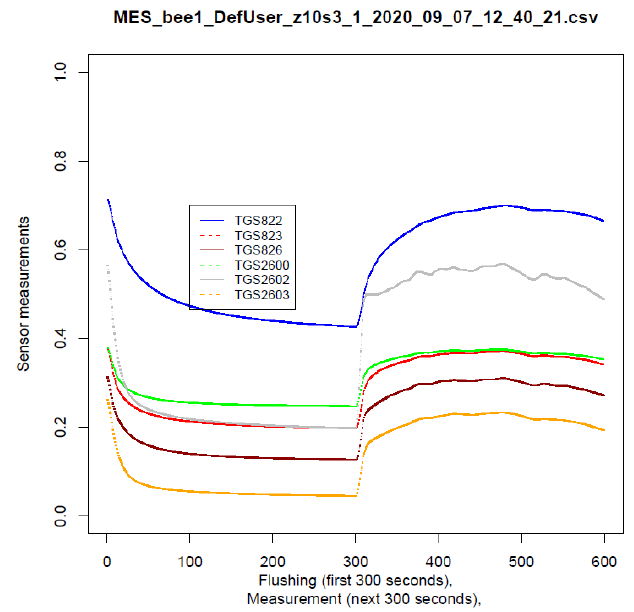
Figure 4. An example of a 600 s gas sensor reading, representing a single measurement. It shows areas where the readings stabilise. The stable areas provide the basis for selecting values for the classification process.